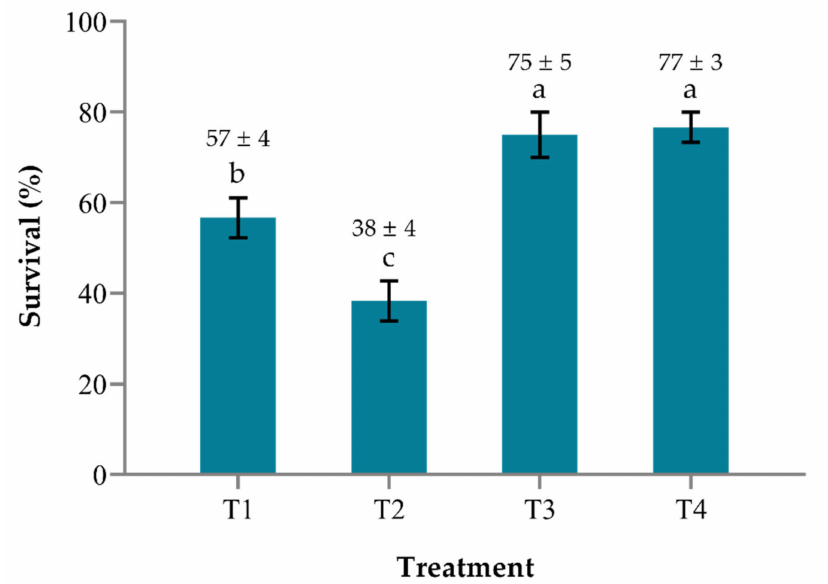
Figure 2. Survival of tilapia larvae fed with Moina micrura pre-enriched with Bacillus pocheonensis after challenged with Streptococcus agalactiae . T1(Tilapia + M. micrura ), T2 (Tilapia + M. micrura + S. agalactiae ), T3 (Tilapia + M. micrura + B. pocheonensis ), T4 (Tilapia + M. micrura + B. pocheonensis + S. agalactiae ). Each value is the mean ± SEM of triplicate analysis. a,b,c bars and mean with different alphabetical letters indicate a statistically significant difference (One-way ANOVA, p < 0.05).